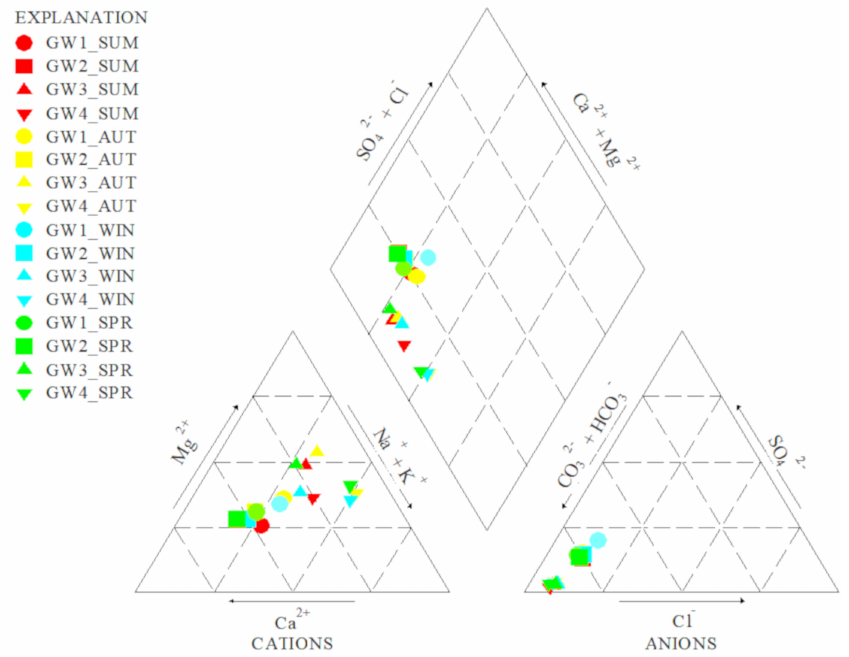
Figure 6. Piper diagram of the studied karstic spring waters.